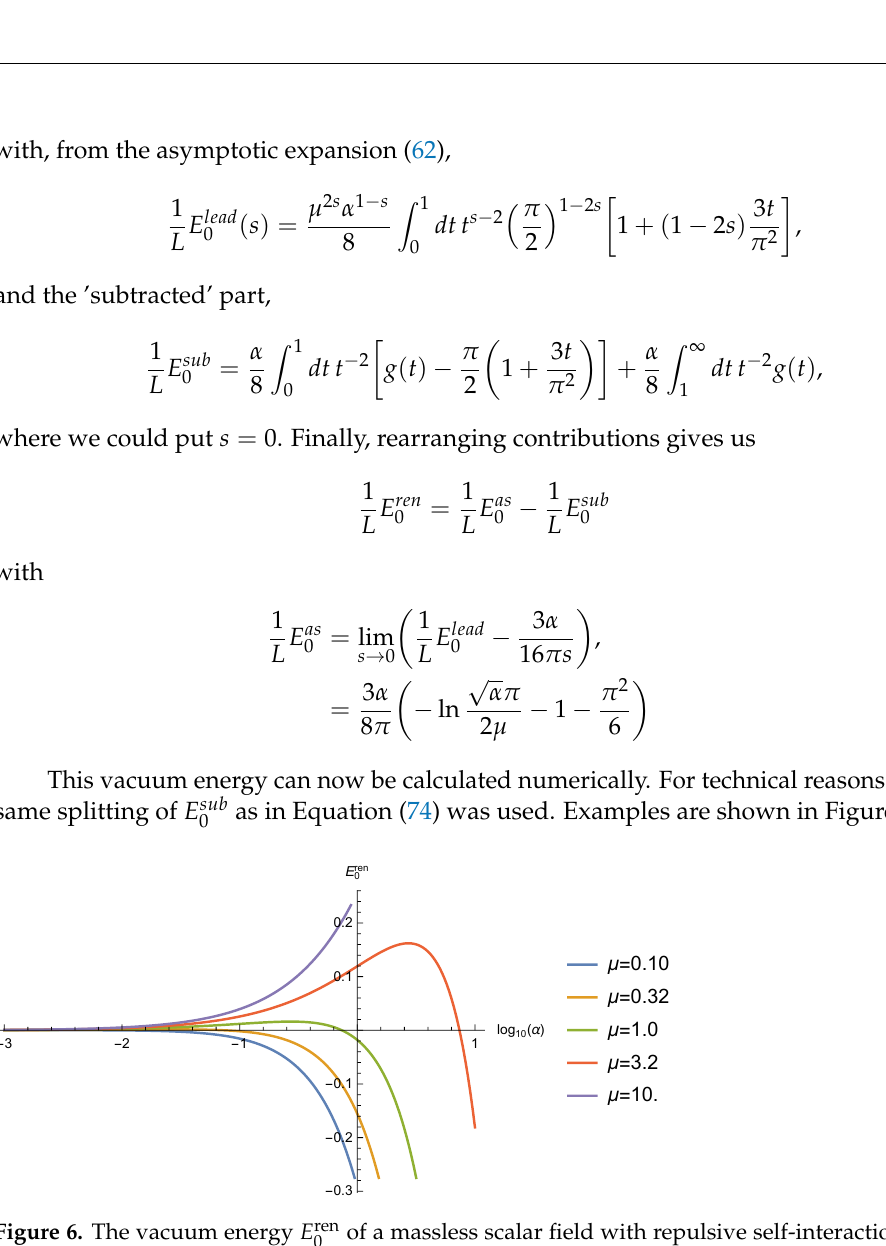
Figure 6. The vacuum energy E ren of a massless scalar field with repulsive self-interaction on the 0 whole axis. E ren and α are given in units of µ 0